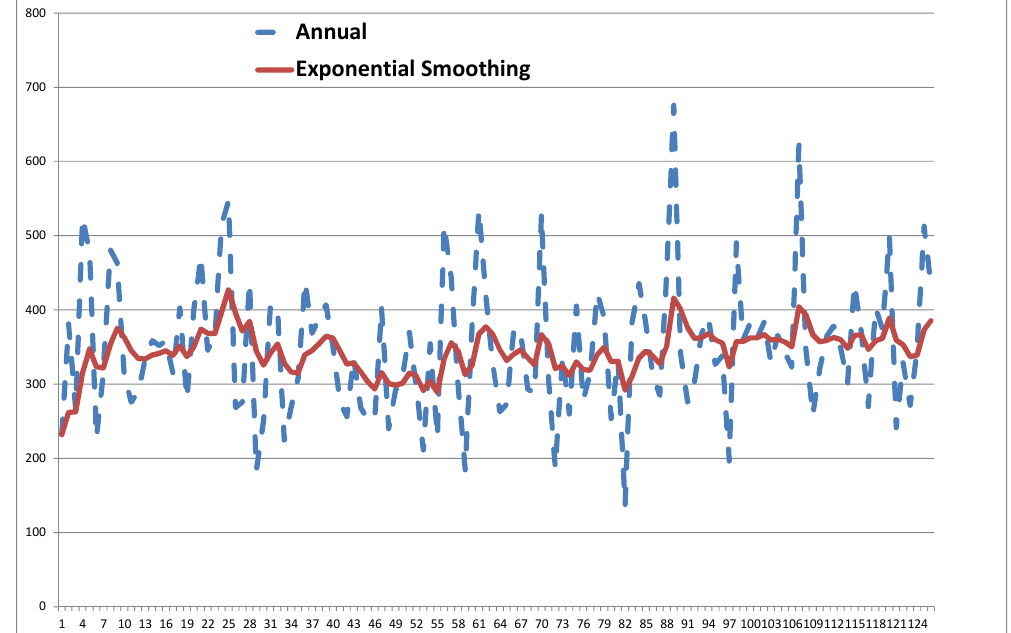
Figure 4. Annual rainfall totals for Murray Bridge from 1886 to